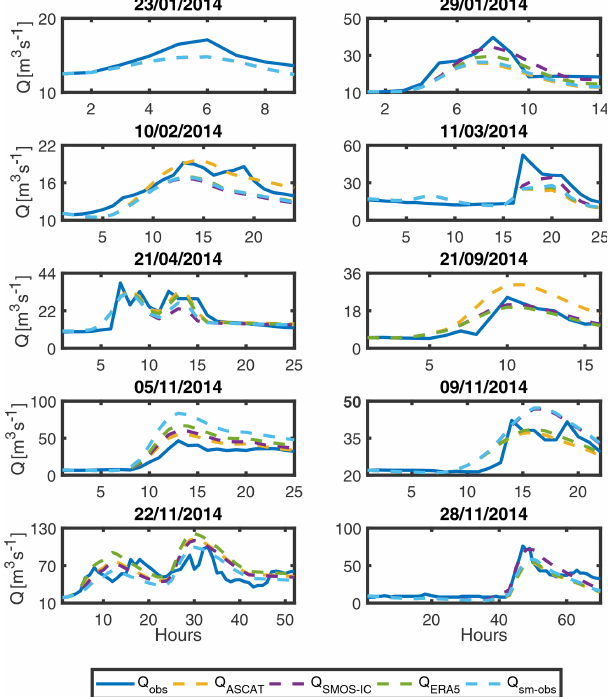
Figure 6. Validation results of flood events simulated for the Rher- aya using different soil moisture products with a daily time step: the observed hydrographs ( Q obs ) are compared to the simulated hy- drographs using ASCAT ( Q ascat ), SMOS-IC ( Q SMOS − IC ), ERA5 ( Q ERA5 ), or observed soil moisture ( Q sm − obs ) to estimate the an- tecedent soil moisture conditions. The selected flood events are de- scribed in Table